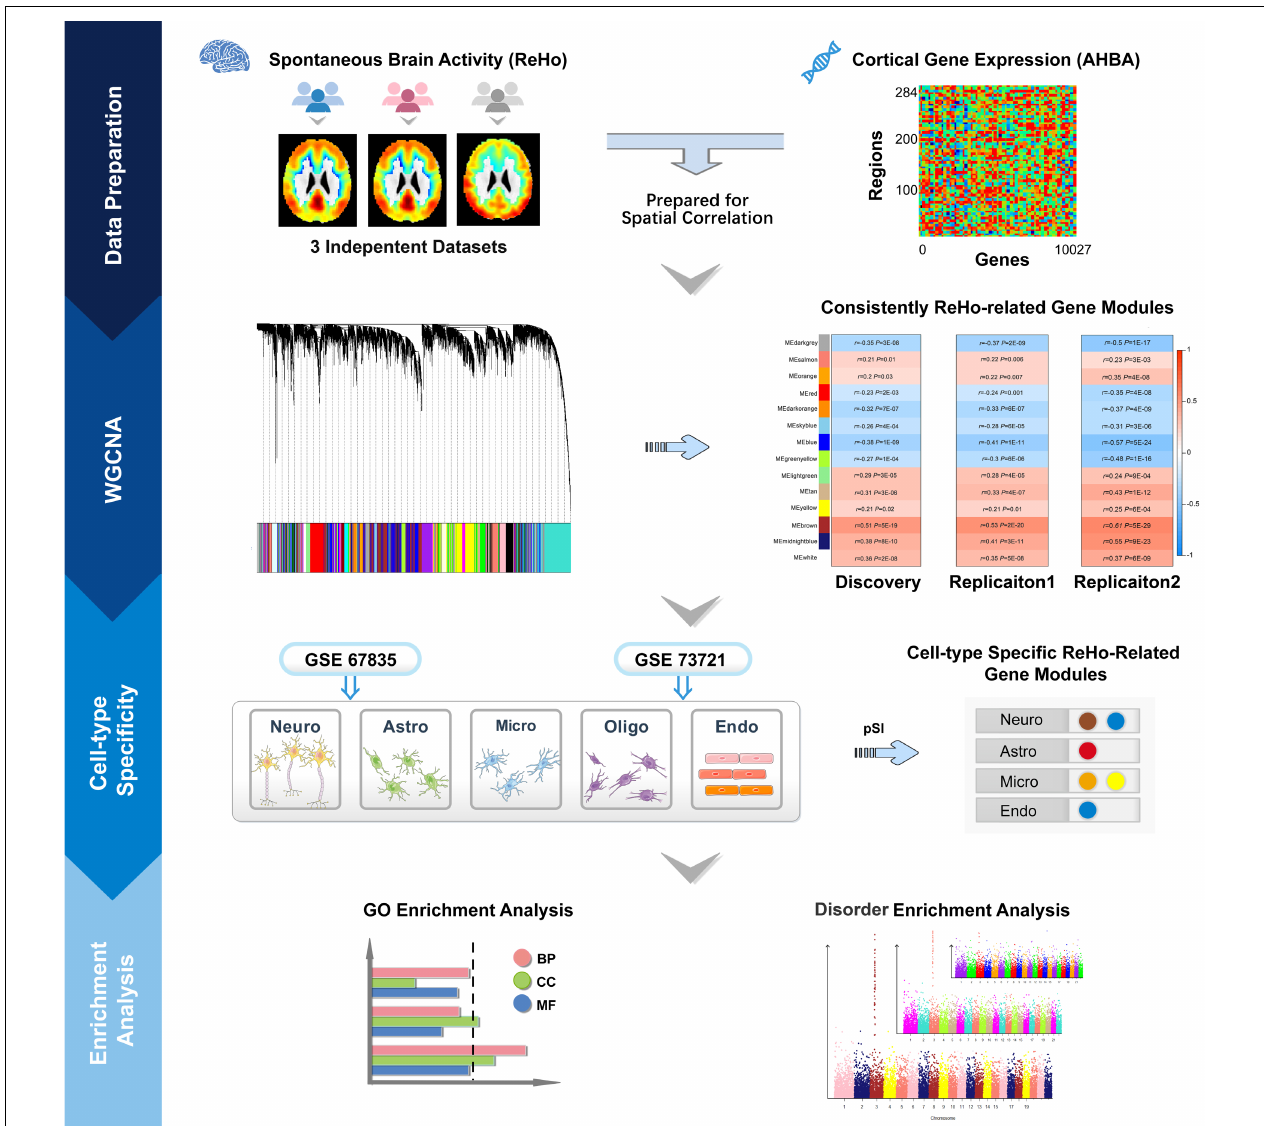
FIGURE 1 | Schematic summary of the study design. This study comprised data preparation, WGCNA, cell-type-specific analysis and enrichment analysis. During data preparation, three mean ReHo maps were obtained from three independent datasets, and a cortical gene transcription matrix was constructed from AHBA. Both ReHo maps and the transcription matrix were assigned to neocortical regions from the HCP Atlas. WGCNA was used to cluster individual genes into gene modules, and spatial correlation was then performed between the ReHo maps and the gene expression profile of each gene module. The significantly correlated gene modules common to the three datasets were considered ReHo-related gene modules. Cell-type-specific analysis was performed for each ReHo-related gene module based on the transcriptomic profiles of neurons, astrocytes, oligodendrocytes, microglia, and endothelial cells from the GSE73721 and GSE67835 series, and the modules that were consistently related to a specific type of neocortical cells in both series were included in the following enrichment analysis. Finally, the identified cell-type-specific modules were annotated by GO and brain disorder enrichment analysis to identify the functions of these modules and to establish their relationships with brain disorders. GO, Gene Ontology; GSE, gene series expression; HCP, Human Connectome Project; ReHo, regional homogeneity; WGCNA, weighted gene coexpression network